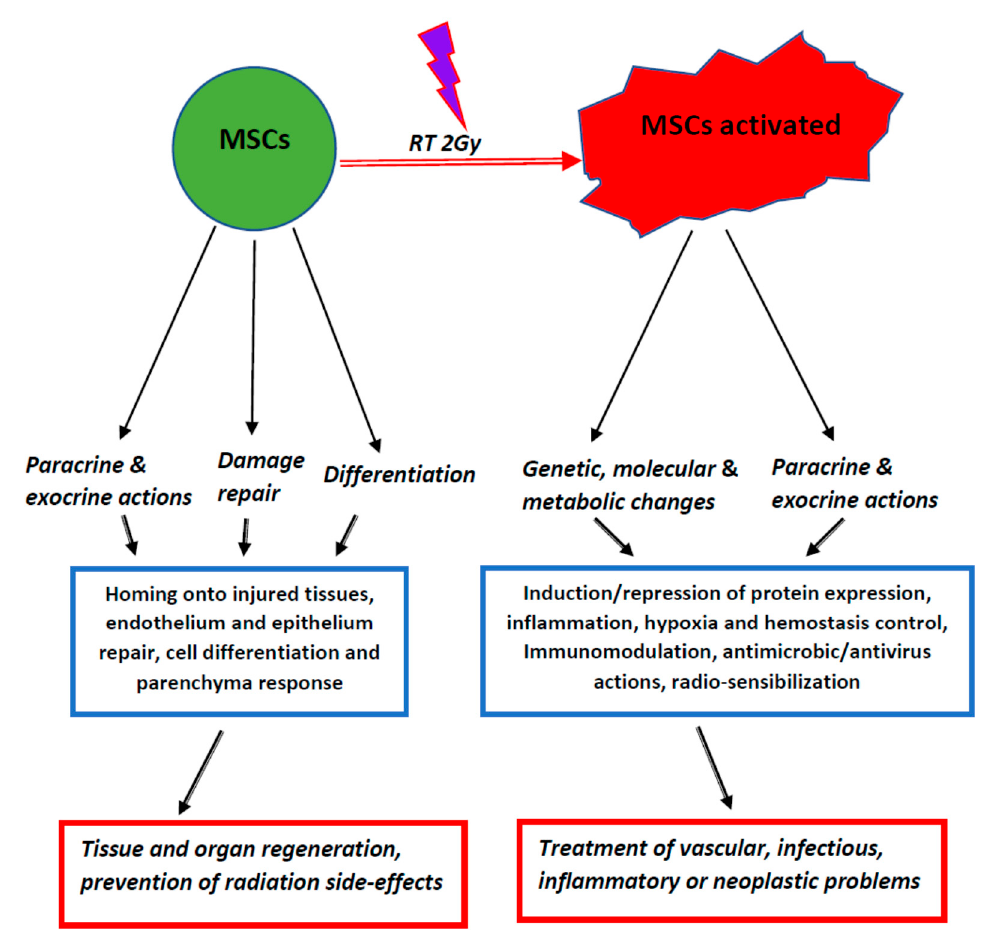
Figure 1. Graphic and schematic summary of cell actions, tissue response and possible therapeutic application of mesenchymal stromal/stem cells (MSCs) and activated MSCs.